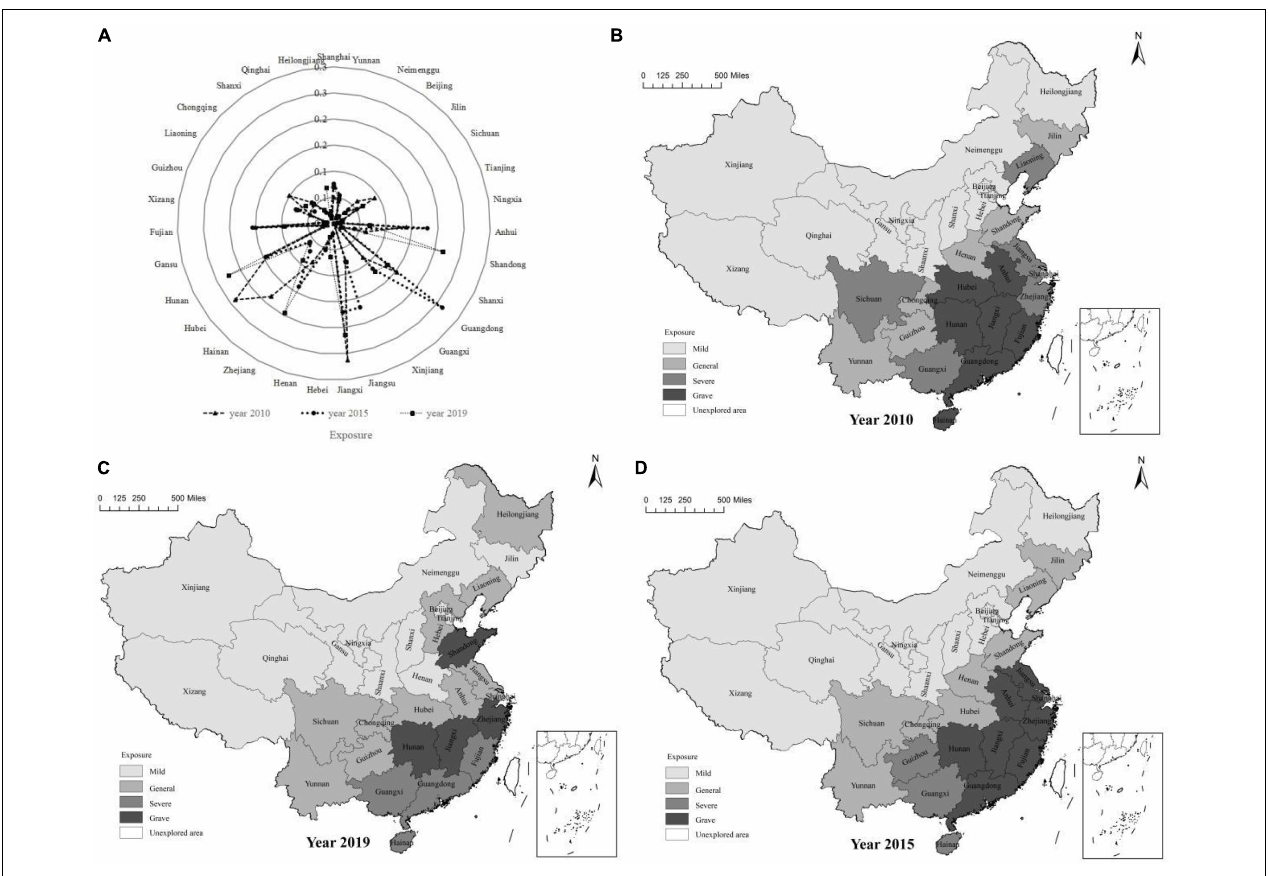
FIGURE 5 | Evaluation results and spatial distribution characteristics of flood disaster exposure of inland fisheries in China from 2010 to 2019. (A) Represents the radar diagram. (B) Represents the year 2010. (C) Represents the year 2015. (D) Represents the year